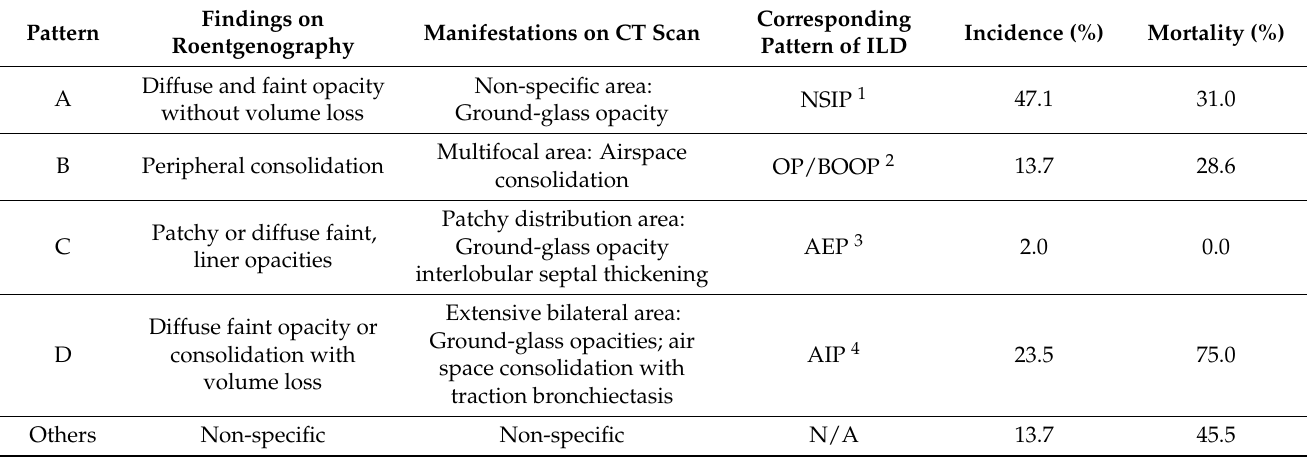
Table 4. Four proposed radiological patterns based on chest roentgenogram and high-resolution CT (HRCT) on acute ILD caused by